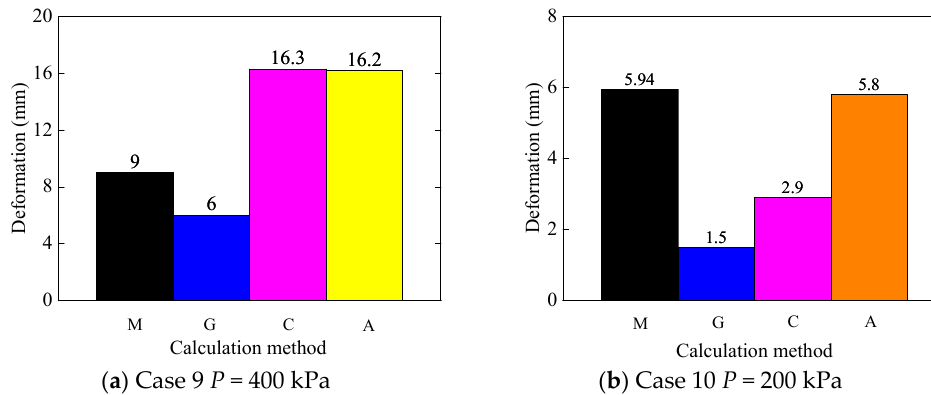
Figure 6. Comparison between measured value and calculated value in cases 9–10 (note: since the calculated values under the FHWA method in case 9 and case 10 are 4209.4 and 74.6, respectively, which are excessively conservative, they are not shown in the figure.).